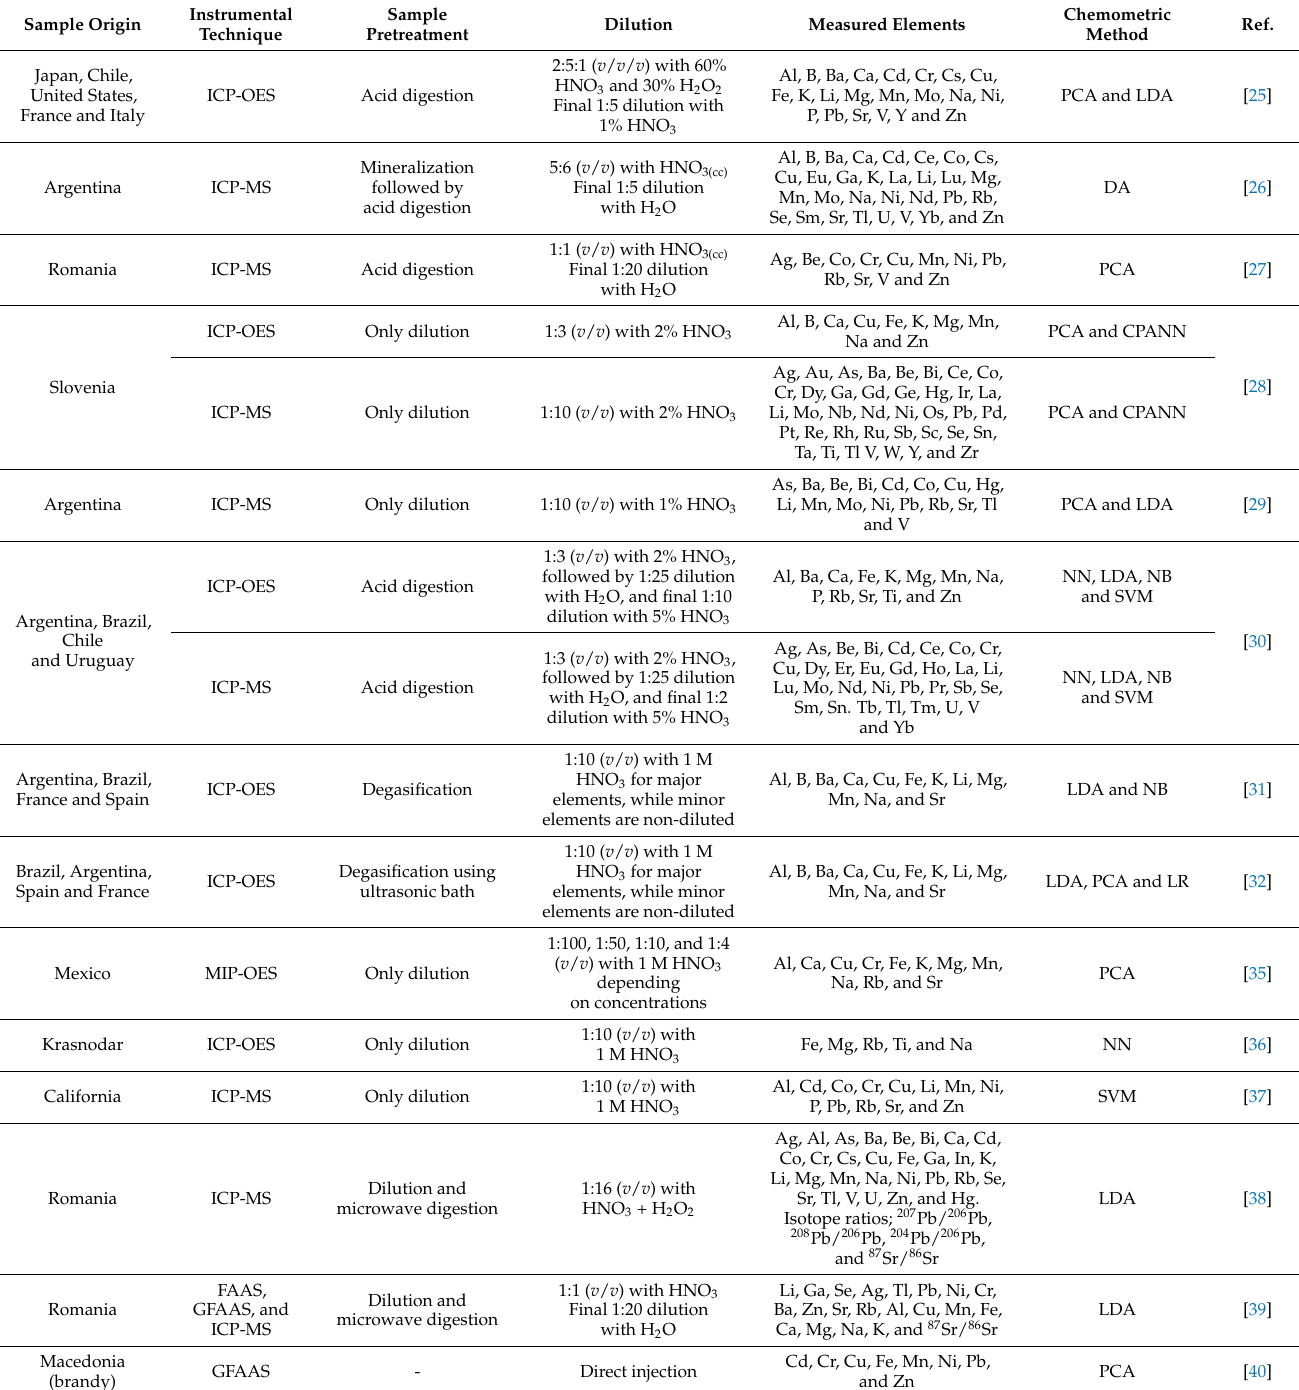
Table 2. Summary of papers published from 2011 to 2021 on the chemometric characterization and authentication of wines and related samples based on elemental